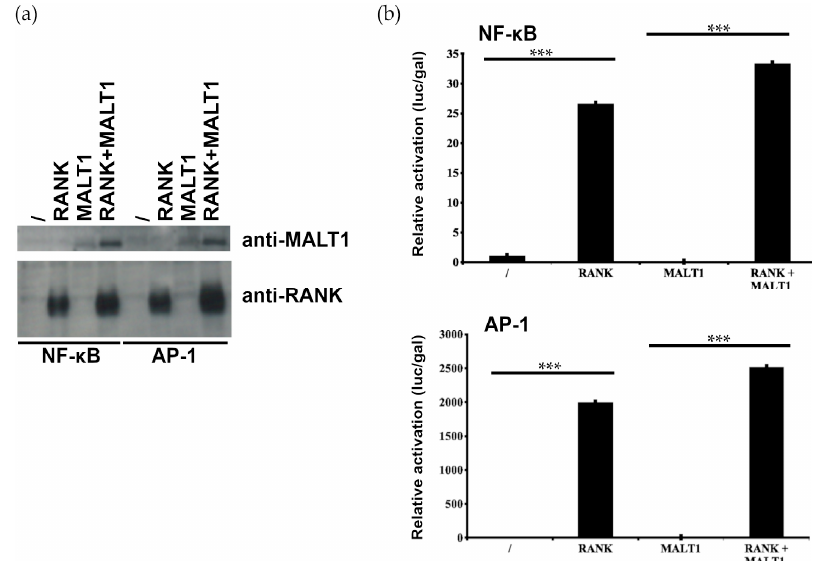
Figure 3. MALT1 is not necessary for RANK-induced NF-kB and AP-1 signaling. MALT1-deficient HEK293T cells or cells reconstituted with MALT1 (as indicated on the X -axis) were transiently transfected with a RANK expression plasmid, a plasmid constitutively expressing β -galactosidase, and plasmids expressing either an NF- κ B-dependent or AP-1-dependent luciferase reporter gene. The / represents set-ups where neither RANK nor MALT1 is expressed. Statistical differences were determined by Student’s t -test, *** represents p ≤ 0.001. ( a ) Expression of MALT1 and RANK was verified by Western blotting. The four left lanes correspond to the samples analyzed in ( b ) for NF- κ B reporter activation, the last four lanes correspond to the samples analyzed in ( b ) for AP-1 reporter activation. ( b ) Luciferase activity was measured 24 h after transfection and normalized to β -galactosidase expression (plotted as luc/gal). Values are the mean of triplicates ± S.D. Data shown are representative of two independent